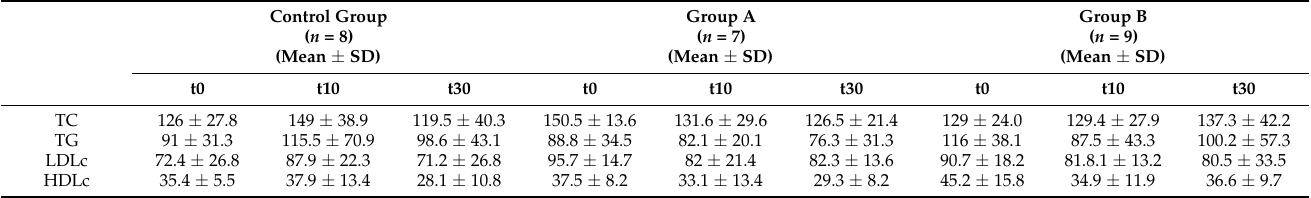
Table 4. Lipid profile of adult women subjected to cryolipolysis on one (group A) or multiple areas of the body (group B).